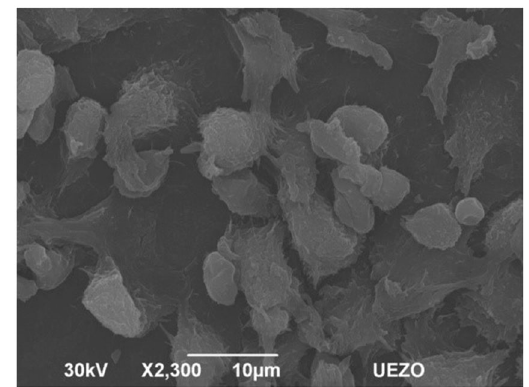
Fig. 6 Micrography of peritoneal macrophages on glass coverslip implant at 30 days after implantation. Magni fi cation 2.3